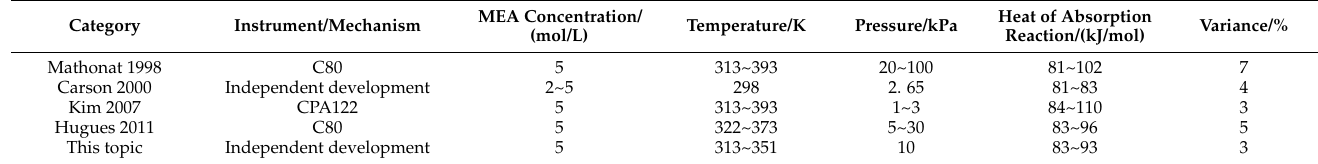
Table 1. Statistical data for absorption heat [2,7,8].